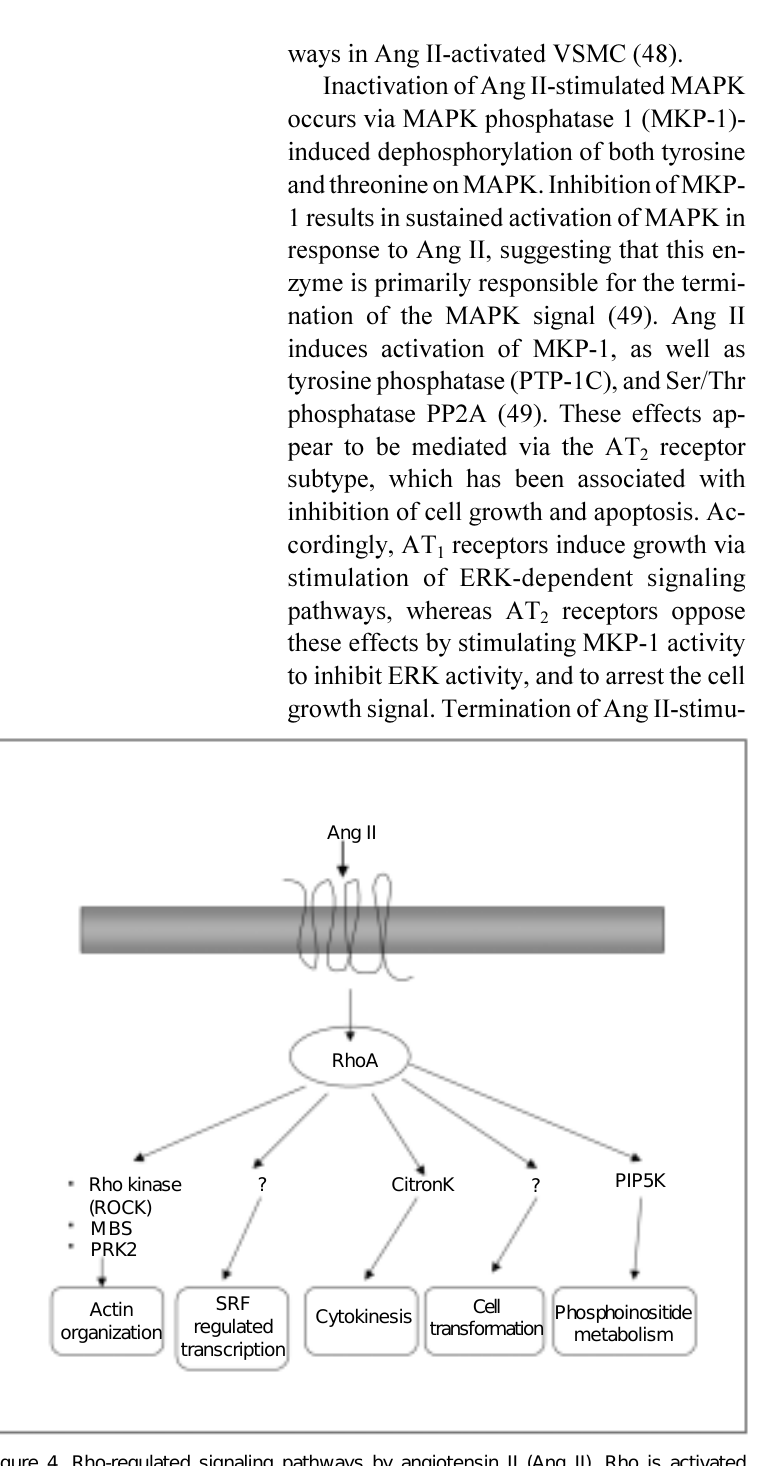
Figure 4. Rho-regulated signaling pathways by angiotensin II (Ang II). Rho is activated through AT 1 receptors. Rho regulates the activity of many signaling pathways that influence contraction, growth and cytoskeletal organization. MBS, myosin binding subunit of the myosin light-chain phosphatase; PRK2, protein kinase C-related kinase; SRF, serum re- sponse